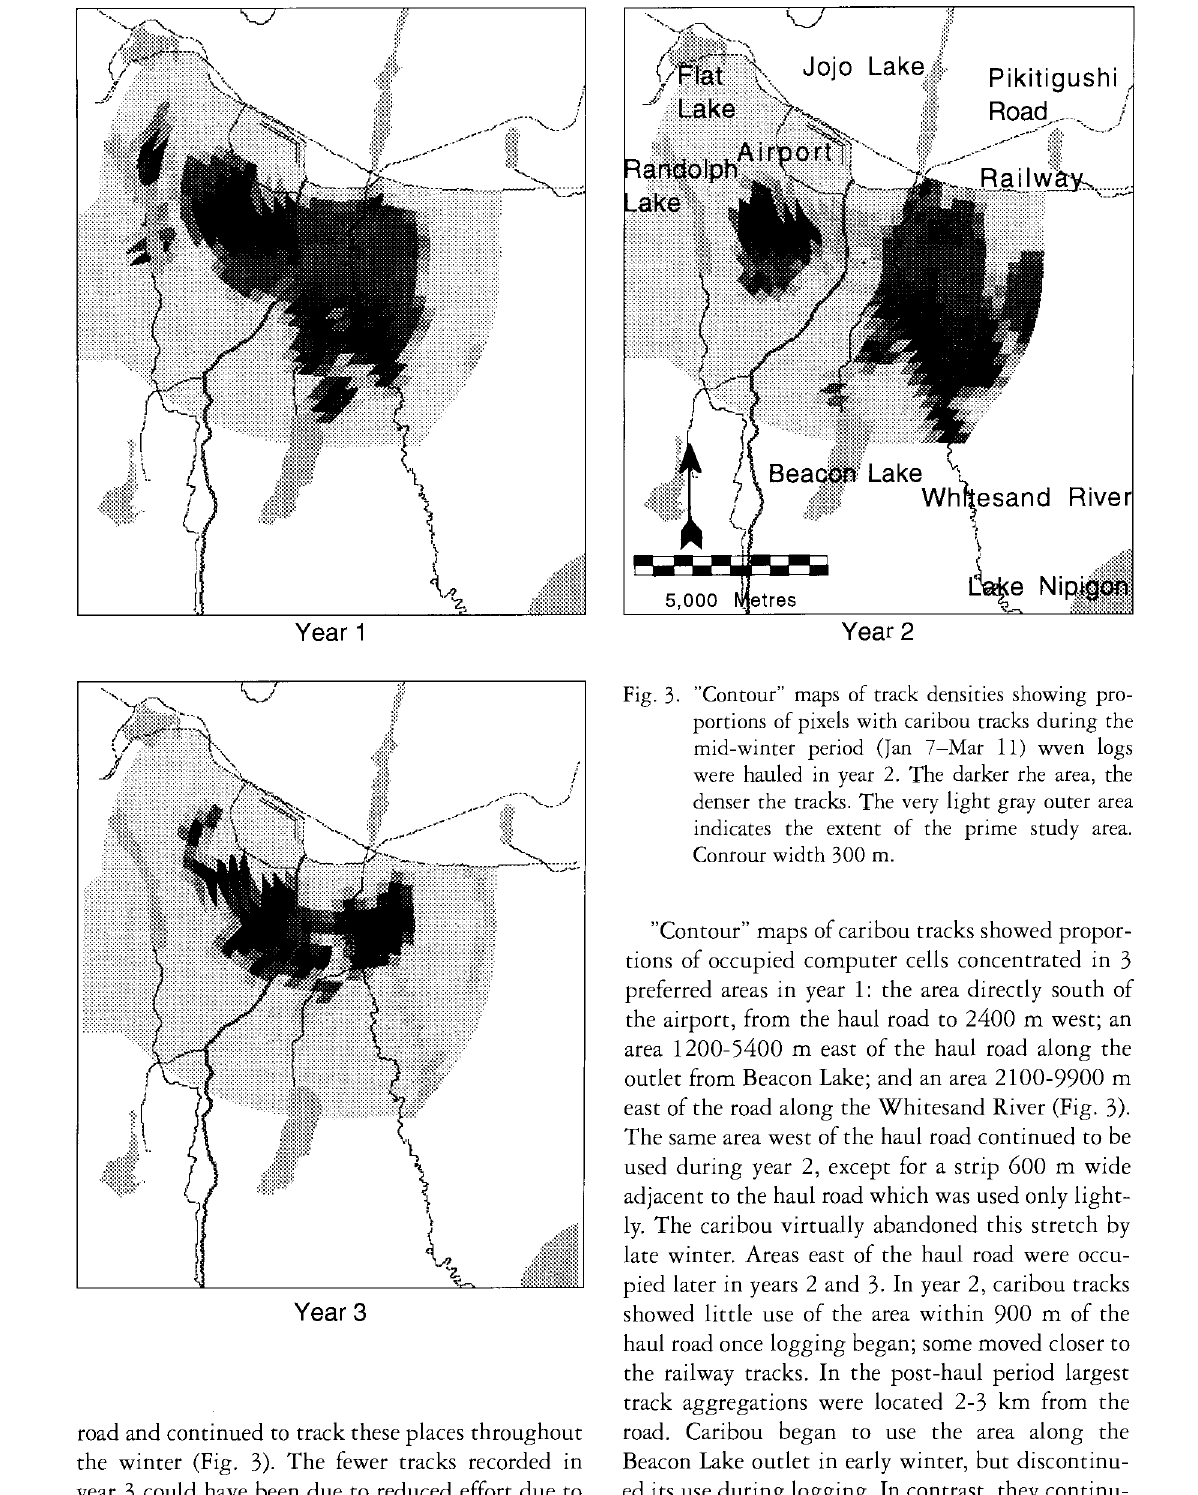
Fig. 3- "Contour" maps of track densities showing pro portions of pixels with caribou tracks during the mid-winter period (Jan 7-Mar 11) wven logs were hauled in year 2. The darker rhe area, the denser the tracks. The very light gray outer area indicates the extent of the prime study area. Conrour width 300